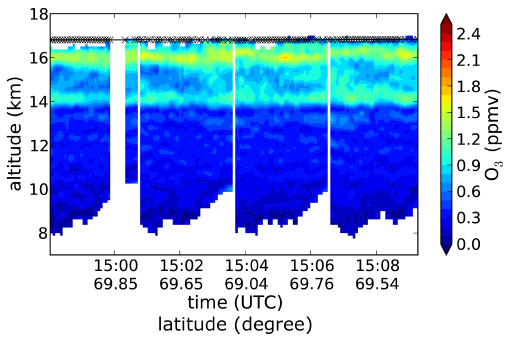
Figure 8. Retrieved ozone volume mixing ratio from GLORIA dynamics-mode data for 16 December 2011. Universal time and geographic latitude (in ◦ ) label the x axis. The figure shows four horizontal sweeps starting at 48 ◦ and ending at 118 ◦ with respect to the airplane